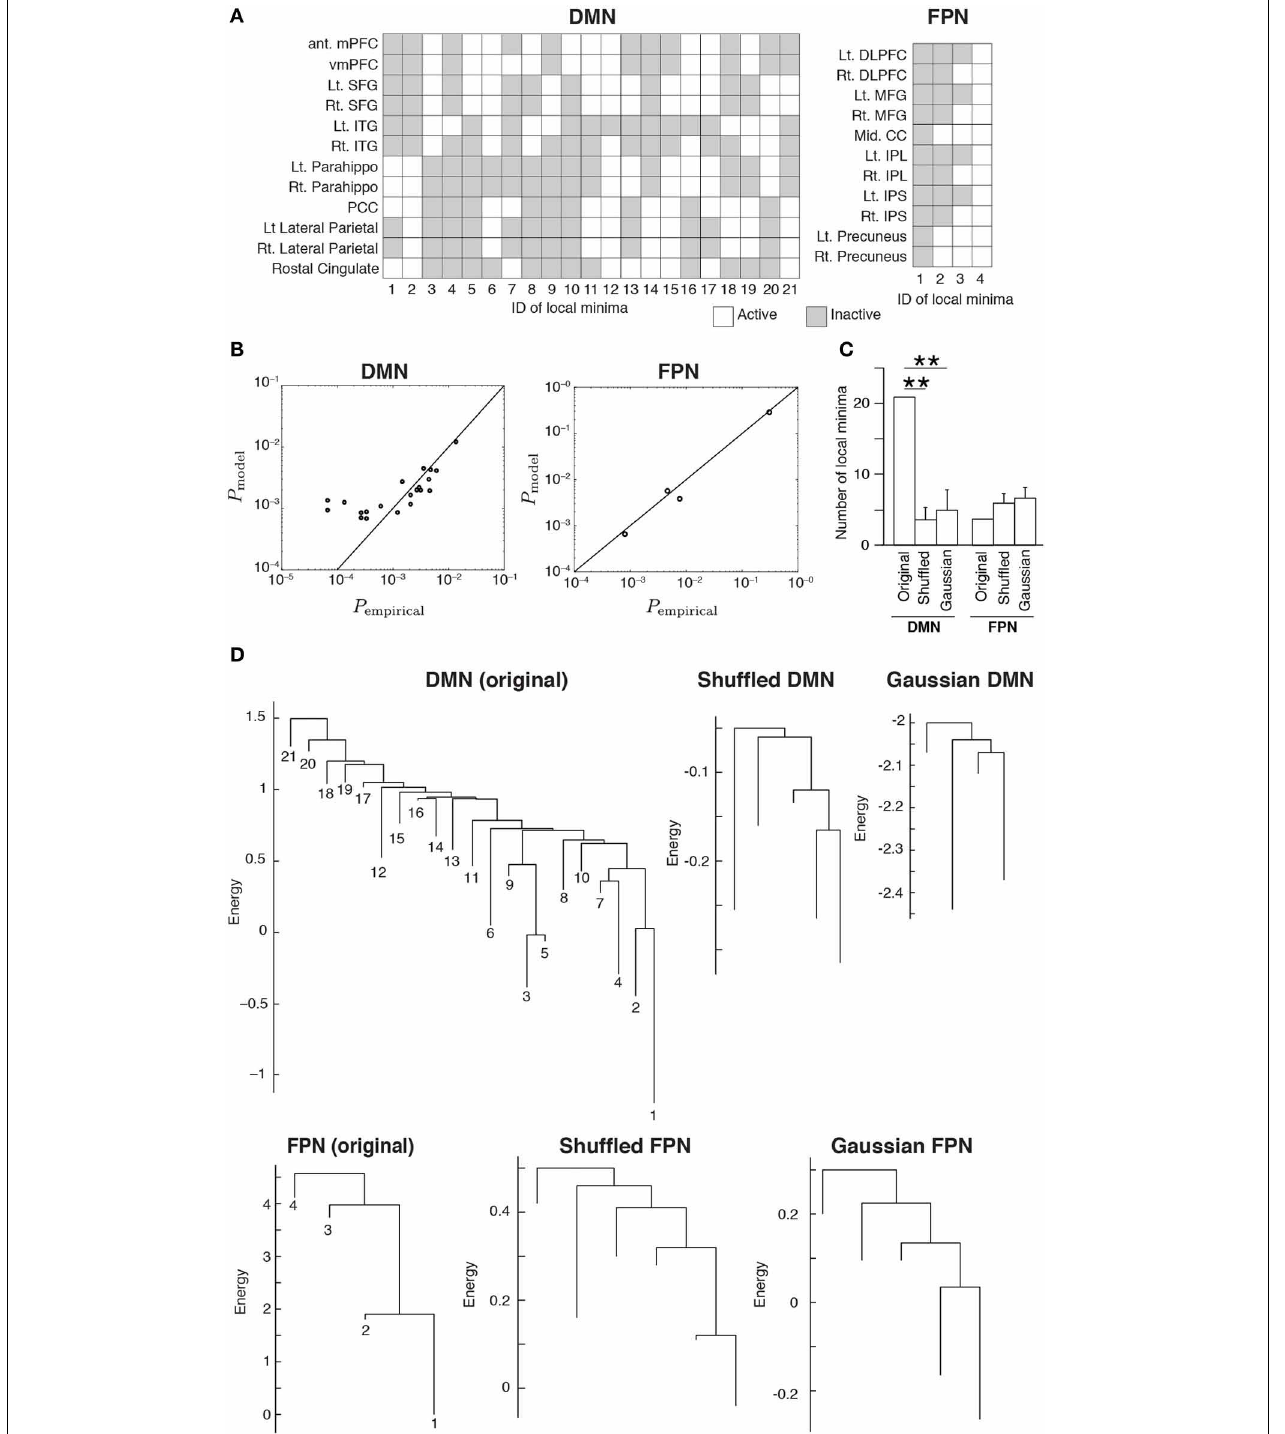
FIGURE 2 | (A) Activation patterns of the local minima. The IDs of the local minimaareshownonthehorizontalaxis.Thelocalminimaaresortedinorderof ascending energy. Each local minimum is specified by an activation pattern, which is an N -dimensional binary vector. The white and gray elements indicate activeandinactivebrainregions,respectively. (B) Comparisonoftheprobability that the local minima are realized between the empirical data and the model. Each circle represents a local minimum. (C) The number of local minima for the